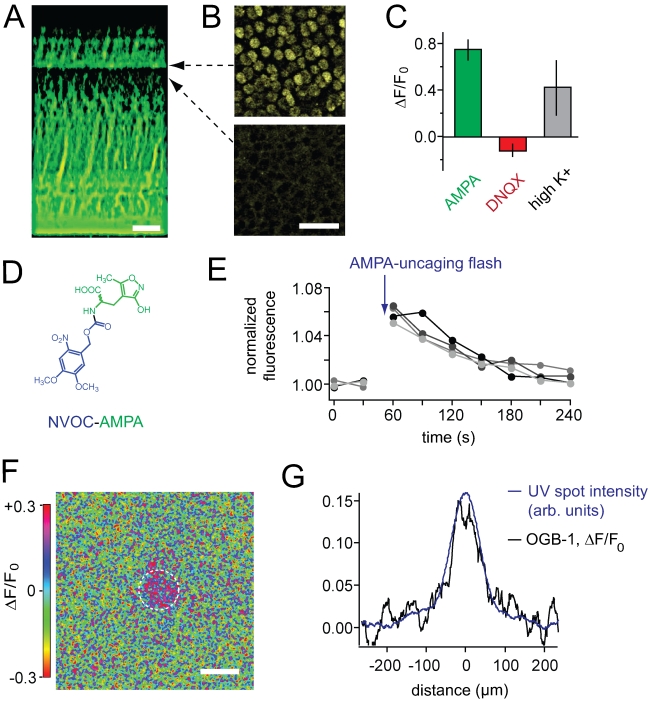
AMPA triggers a rise in Ca2+ in the cone synaptic
terminal.Incubating anole retina with 100 µM of the AM-ester form of Oregon
Green BAPTA-1 (OGB) resulted in robust loading of Ca2+
indicator dye into cone terminals. (A) A “virtual slice” of
a flat-mounted retina loaded with OGB, rendered using a z-stack of 80
cross-sectional images. Images were taken at 2 µm intervals
through the entire retina using a 2-photon microscope. Labeling is
selective for photoreceptors (top) and retinal ganglion cells and Muller
glial cells (bottom). (B) Representative cross-sectional images of OGB
fluorescence in a flat-mounted retina. Cone terminals (top) are brightly
labeled, while the region of the INL immediately below the cone
terminals is not (scale bar  =  20 µm, A,B).
(C) Average peak OGB-1 fluorescence change caused by AMPA
(n = 5), DNQX
(n = 4), and high
K+ (n = 5).
(D) NVOC-AMPA, a photolyzable agonist for selective optical activation
of AMPA receptors. (E) Four uncaging trials from an OGB-1-loaded retina
show that uncaging NVOC-AMPA (50 µM) with UV light triggers rapid,
reversible increases in cone terminal Ca2+. (F) OGB-1
fluorescence increase in a flat-mounted retina triggered by flash
uncaging of NVOC-AMPA. The dotted circle represents the full-width
half-maximal of the Guassian region of uncaging. Scale bar
 =  100 µm. (G) Profile of the OGB-1
fluorescence increase in a flat-mounted retina and of the UV uncaging
spot.